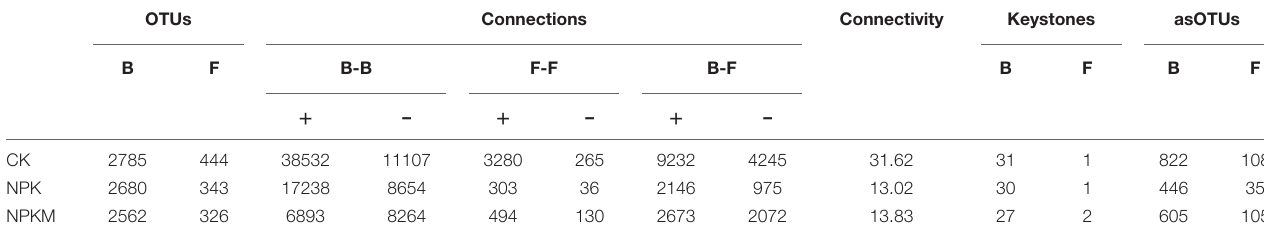
TABLE 1 | Properties of bacterial and fungal co-occurrence networks in different fertilization regimes. OTUs Connections Connectivity Keystones